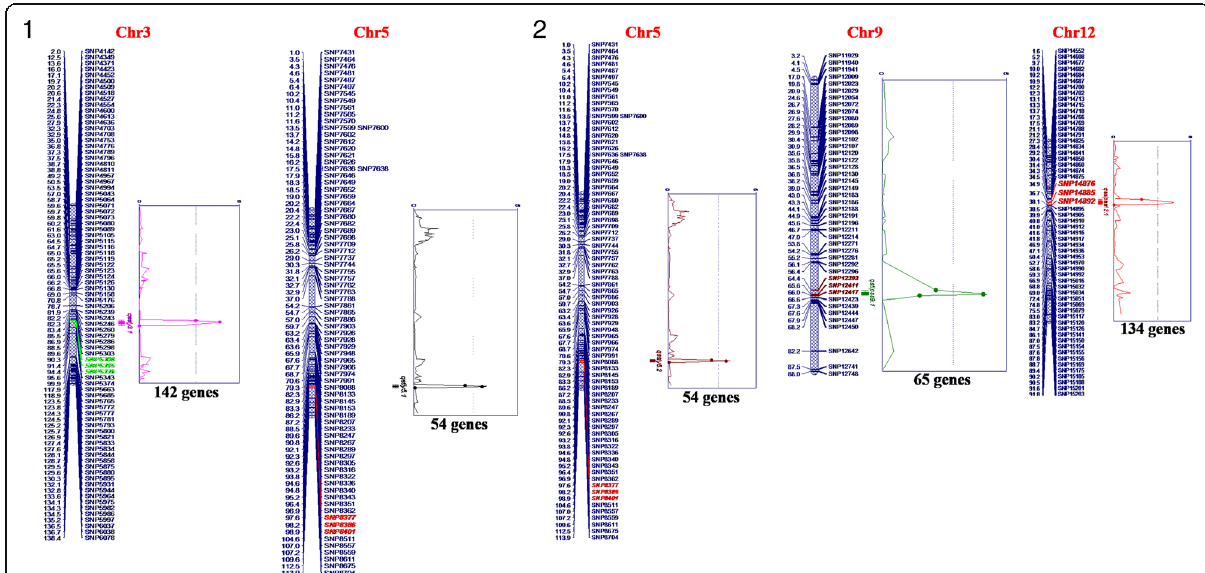
Fig.4 QTLs identified for heat tolerance in rice in the mapping population derived from Nagina22 and IR64